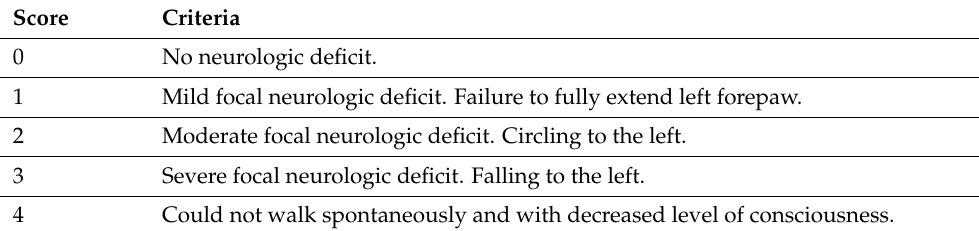
Table 1. Neurological scoring